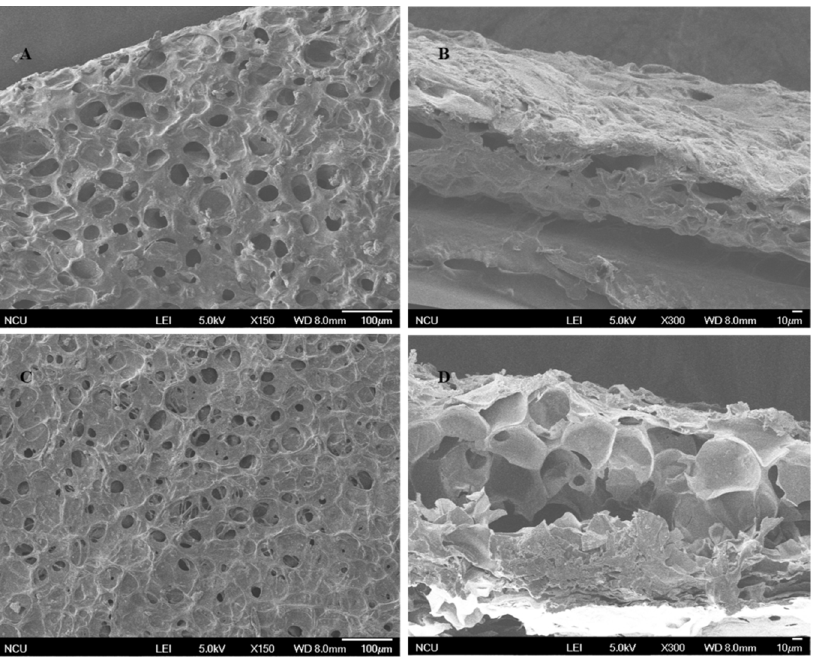
Figure 1. SEM images of the surface ( A , C ) and cross-section ( B , D ) of MICM ( A , B ) and NMICM ( C , D ).